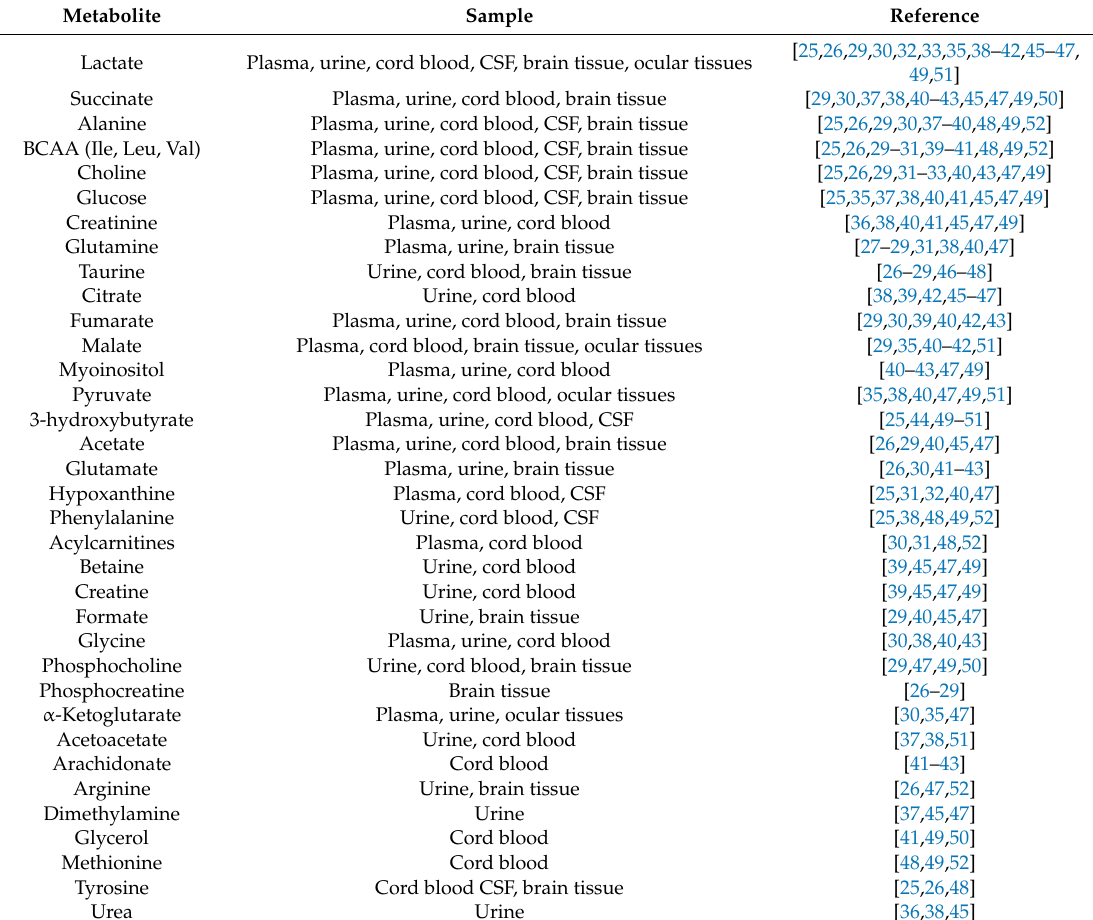
Table 3. Potential biomarkers of PA in animal and human